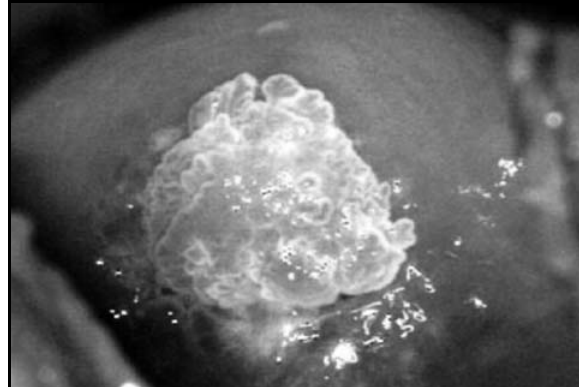
Figura 5 – Imagem colposcópica de condiloma acuminado típico: lesão acetorreativa com projeção digitiforme com eixo vascular central e superfície irregular